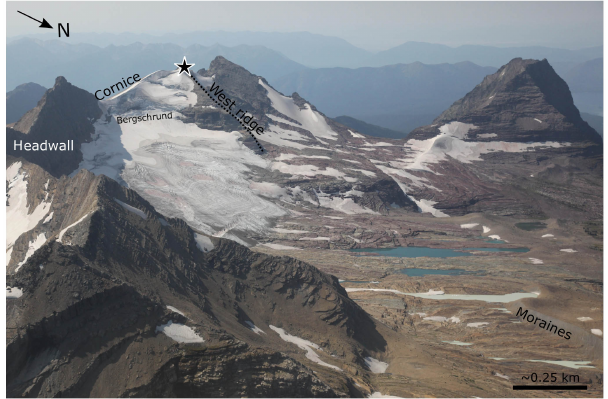
Figure 2. Sperry Glacier on 1 September 2009. Arrow points to the north. Note low-sloping proglacial terrain. In 1950 and 1960, the glacier extended onto this relatively flat ground. Gunsight Peak is indicated by the black star. The west ridge, headwall, cornice, bergschrund, and moraines discussed in the text are labeled. Photo- graph credit: USGS Climate Change in Mountain Ecosystem pho- tograph